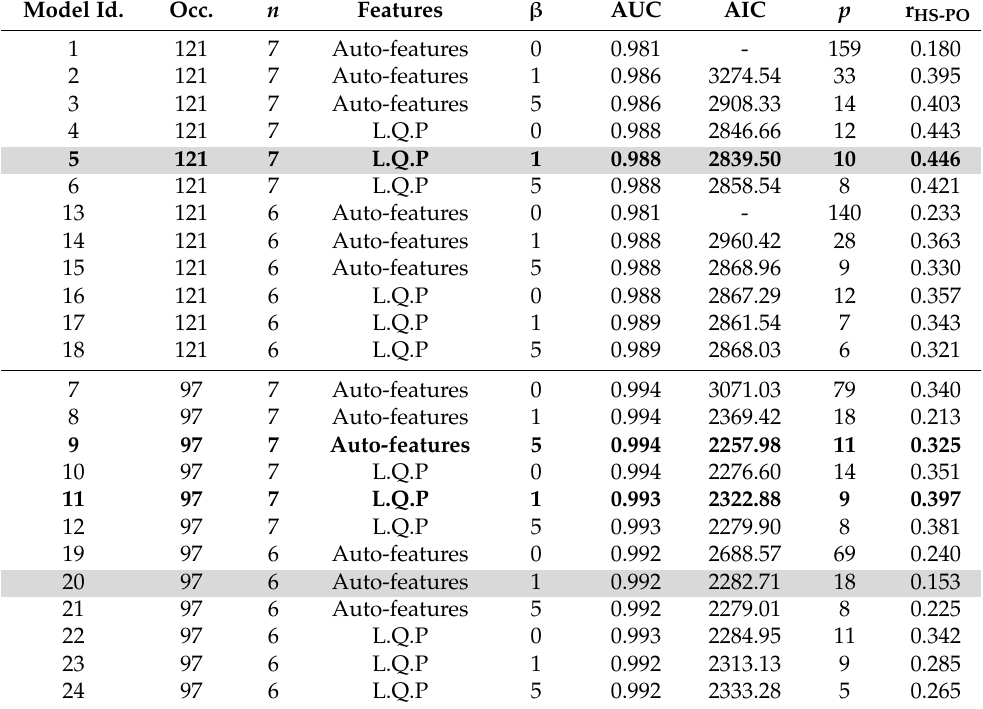
index (r HS-PO ) of the models differing only from the occurrence data set, better models were also observed on those calibrated with Mexican data (data set 1). Table 4. Characterization of the different distribution models. Model Id.: Identification number of the model). Occ: Occurrence data (97 Mexican occurrences. 24 Guatemala and Honduras occurrences). n : number of independent variables included in the model. Features: features classes allowed in the modeling process. L.Q.P: Linear, quadratic and product features. β : Maxent β -multiplier. AUC: Area Under the receiver operating characteristic curve. AIC: Akaike Information Criterion corrected for small sample sizes. p : number of parameters of each model. r HS-PO : Spearman correlation between habitat suitability values (HS) and the percentage occupation (PO) of P. hartwegii on the 2013 satellite derived map. Shadowed in gray: best and worst model r HS-PO model. Bold: best models. Model